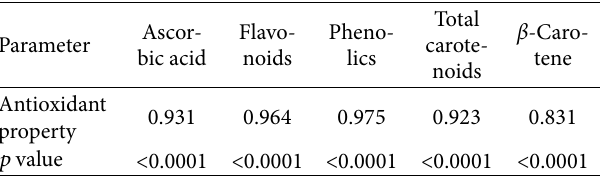
Table 5: Tannins and soluble oxalates (dry basis) in leaves and roots of nine Kenyan sweet potato varieties.